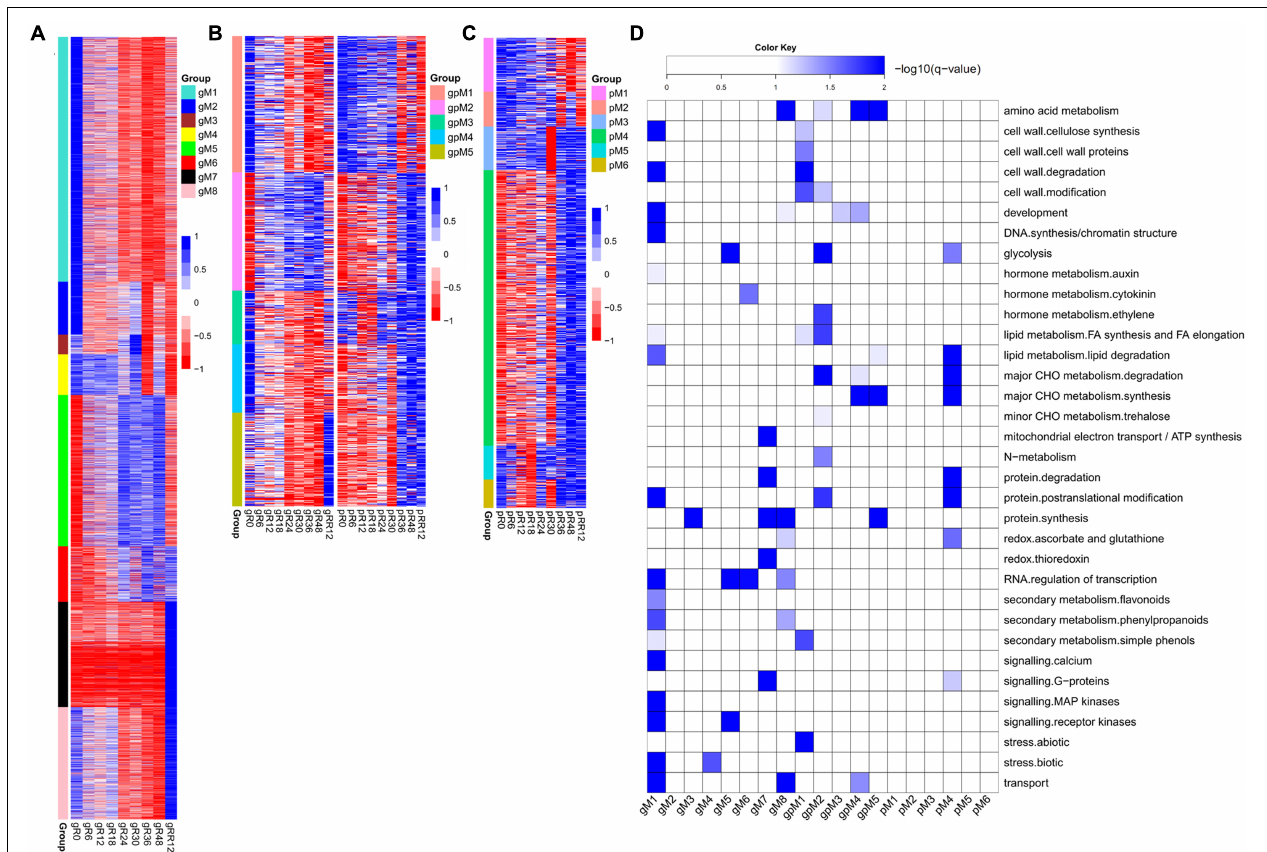
FIGURE 2 | Dynamic and stage-specific expression changes of genes and proteins upon flooding stress. (A) Profiles of DEGs identified exclusively at the transcriptomic level. A total of eight groups (gM1–gM8) were determined according to their expression patterns. (B) Profiles of DEGs/DEPs identified at both the transcriptomic and proteomic levels. Five groups (gpM1–gpM5) were found. (C) Profiles of DEPs identified exclusively at the proteomic level. Six groups (pM1–pM6) were found. (D) Functional category enrichment of DEGs/DEPs corresponding to those identified in (A–C) . The samples/groups are prefixed as follows: g, transcriptomic level; p, proteomic level; gp, both transcriptomic and proteomic